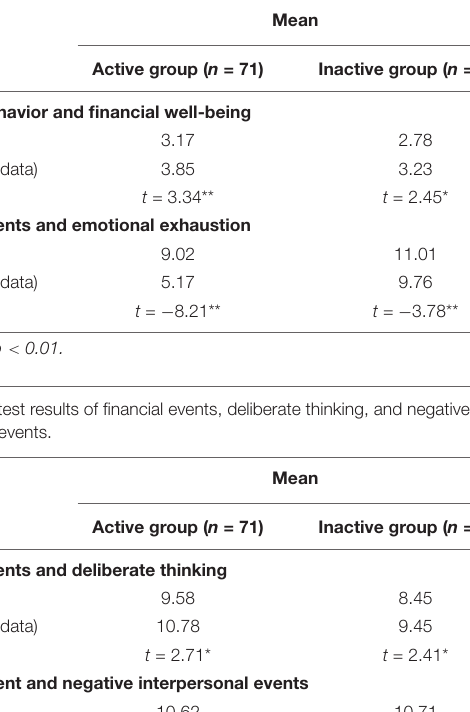
TABLE 2 | T -test results of financial behavior, financial well-being, financial events, and emotional exhaustion.